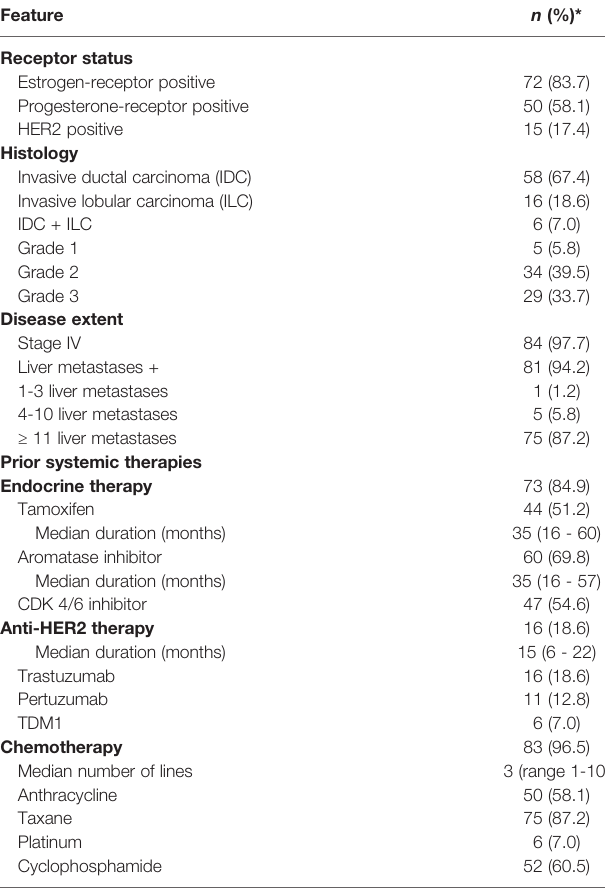
TABLE 2 | Complications and other characteristics of pseudocirrhosis (n = 86, unless speci fi